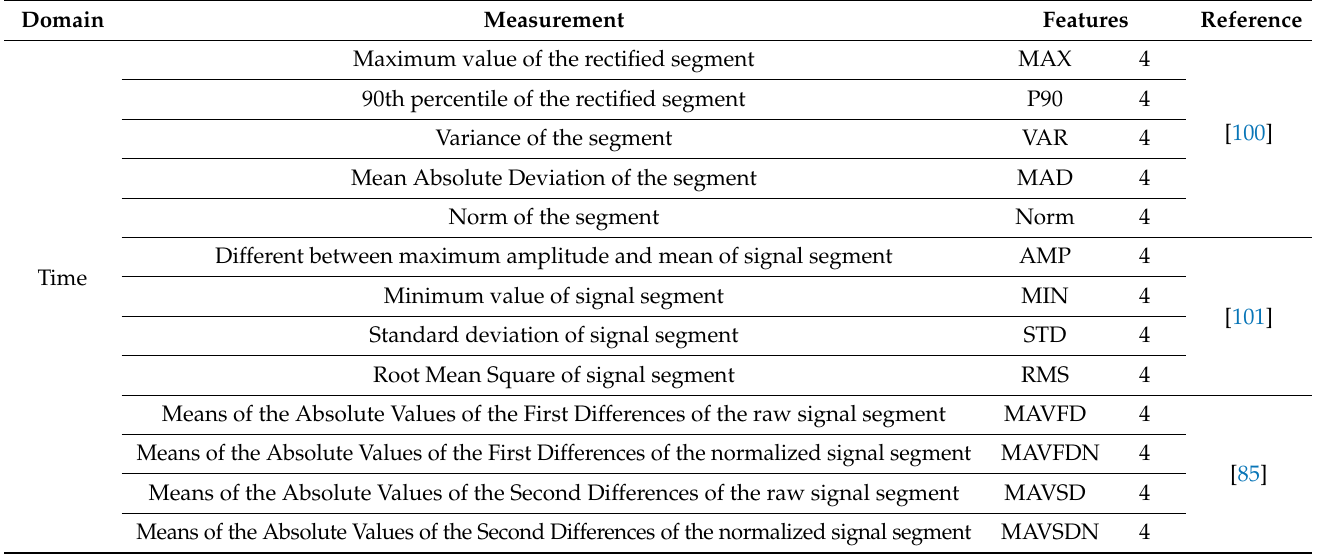
Table 7. Accelerometer